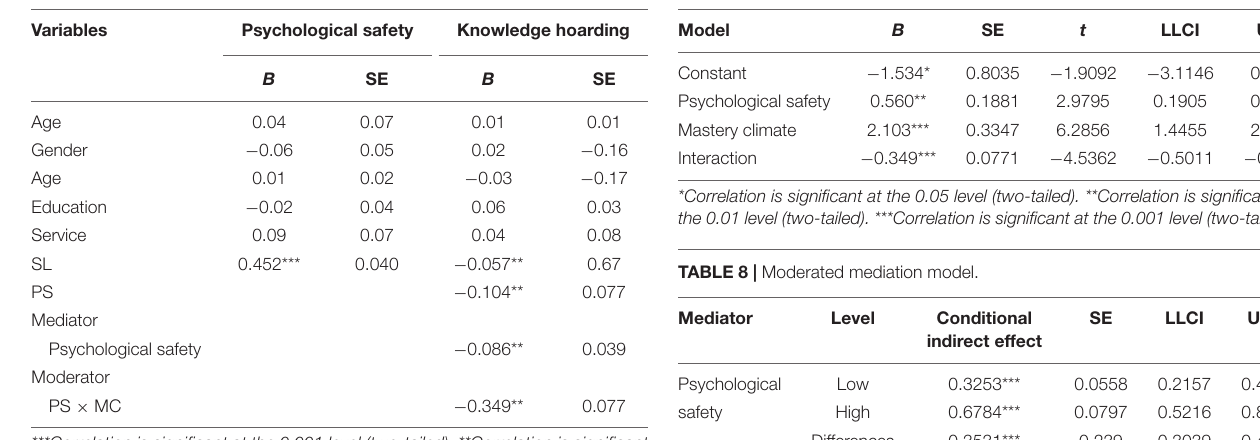
TABLE 7 | Moderation analysis.